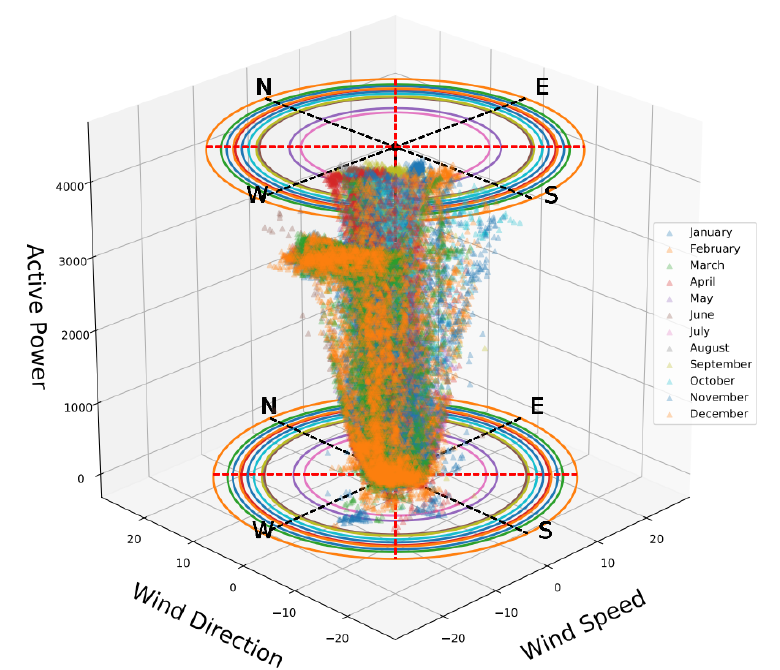
Figure 8. Wind turbine Scada dataset 3D visualization in cylindrical